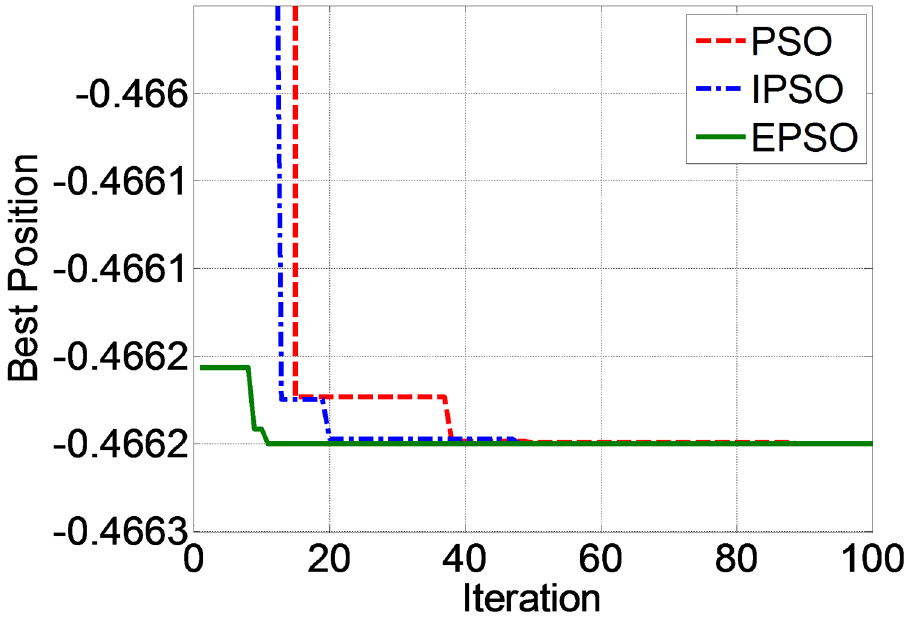
Fig 4. Best position vs. iteration for PSO, IPSO and EPSO techniques (closer